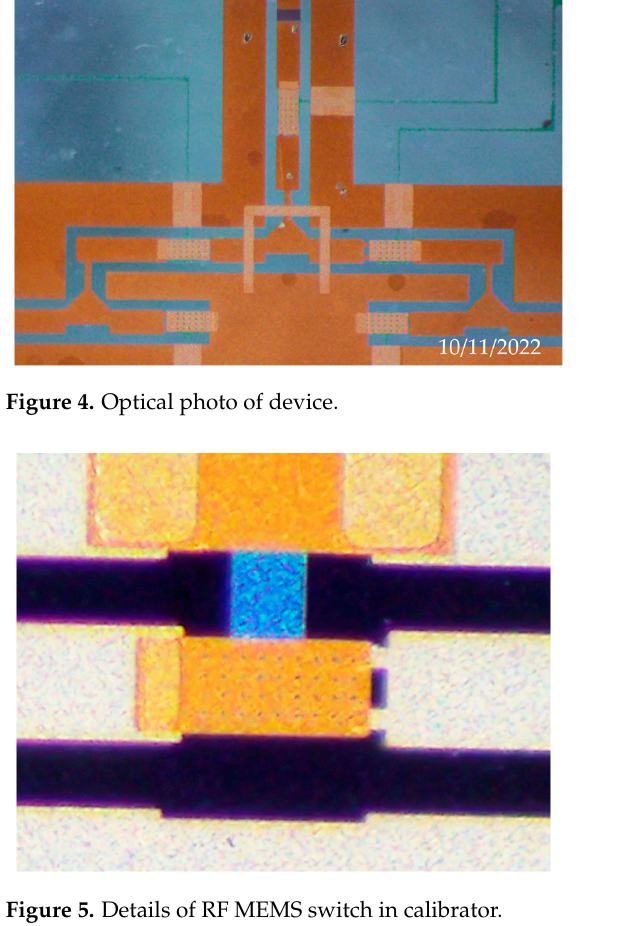
Figure 5. Details of RF MEMS switch in calibrator.